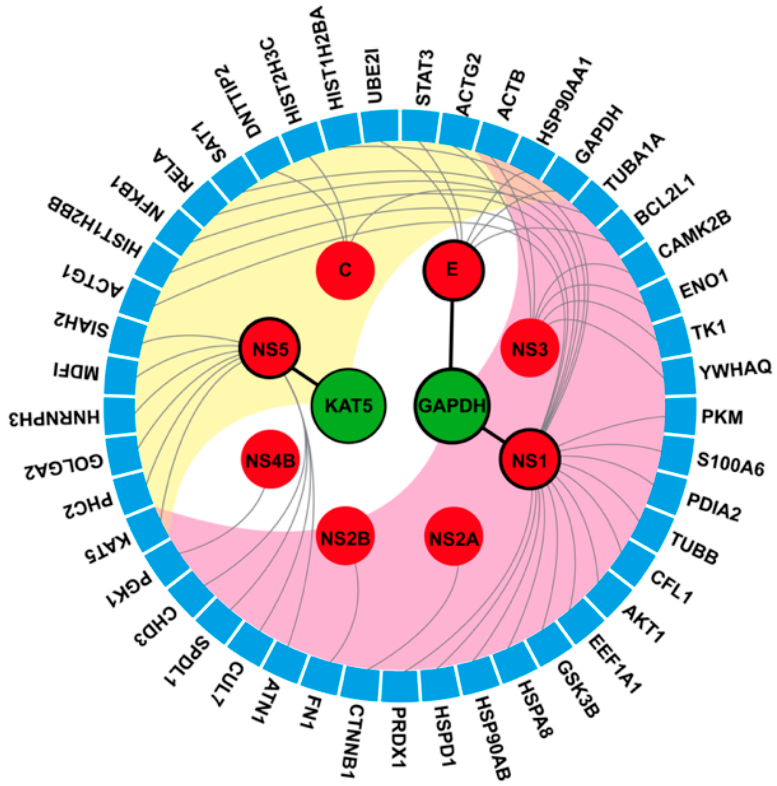
Figure 5. Protein-protein interaction (PPI) illustrated as a chord diagram. The predicted targets, KAT5 and GAPDH (green node), directly interact with three viral proteins (red node with black border) shown by black line. The associated viral proteins (red node without border) links to the second level of interacted proteins (blue segment) represented by the grey linkage. The connections between the predicted targets (KAT5 and GAPDH) and the second level of interacting proteins (blue segment) were defined by the pink and yellow color.